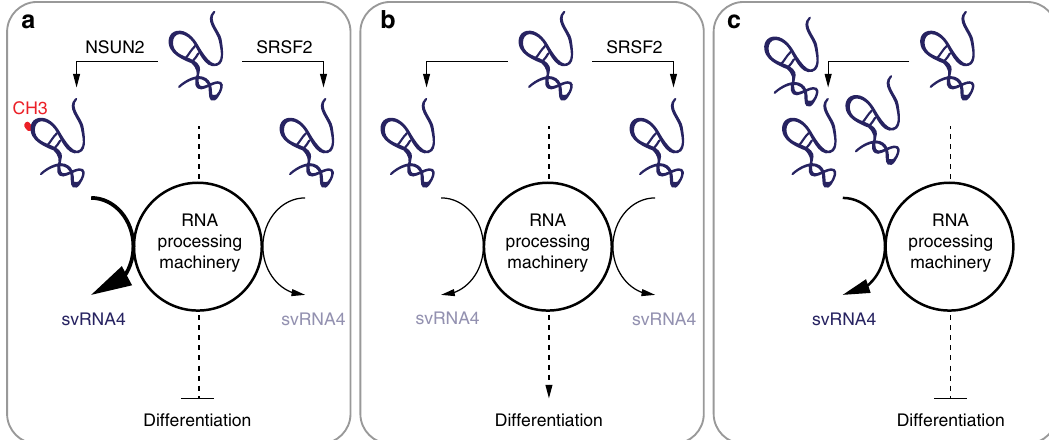
Fig. 6 Summary of VTRNA1.1 processing into svRNA4. a Expression of both NSUN2 and SRSF2 (e.g. in progenitor cells) result in high levels of VTRNA1.1 methylation (CH 3 ) and high levels of svRNA4 and repressed differentiation. b No NSUN2 in the presence of SRSF2 suppresses formation of svRNA4 and allows differentiation. c Lack of expression of both NSUN2 and SRSF2 release VTRNA1.1 from SRSF2 binding and increases the levels